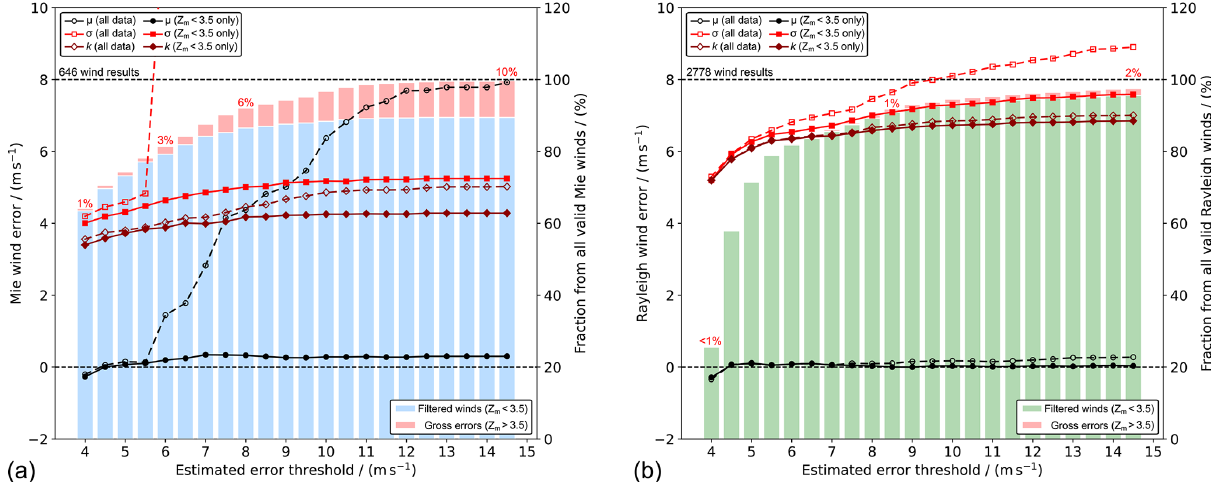
Figure 6. Results from the statistical comparison of L2B Mie-cloudy (a) and Rayleigh-clear winds (b) against ECMWF model background wind data from the AVATAR-T campaign, depending on the EE threshold without and with outlier removal based on the modified Z score. The bar plots depict the portion of filtered winds after QC ( | Z m | < 3 . 5; blue and green bars) and gross errors ( | Z m | > 3 . 5; red bars) from all wind results that are flagged valid in the L2B product and pass the specified EE threshold. The portion of gross errors is indicated above the bars. The dashed lines and open symbols refer to the statistical results (mean bias µ , standard deviation σ , and scaled MAD k) without removing the gross errors from the datasets, while the solid lines represent the statistical parameters after QC based on the modified Z